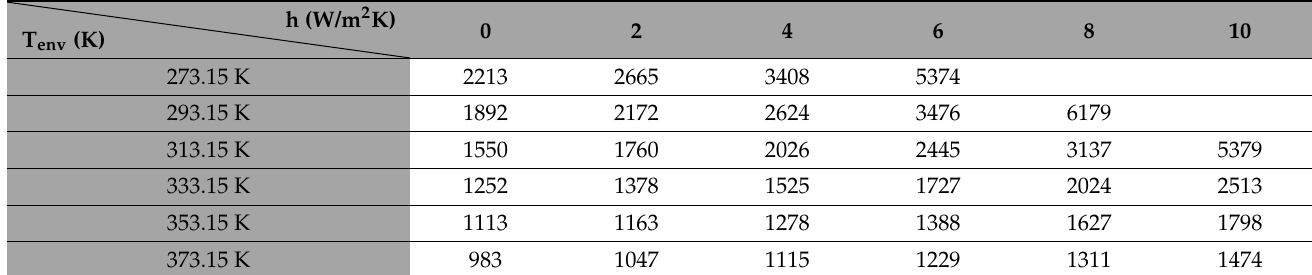
Table 5. Ignition time (s) at different h (W/m 2 K) and ambient